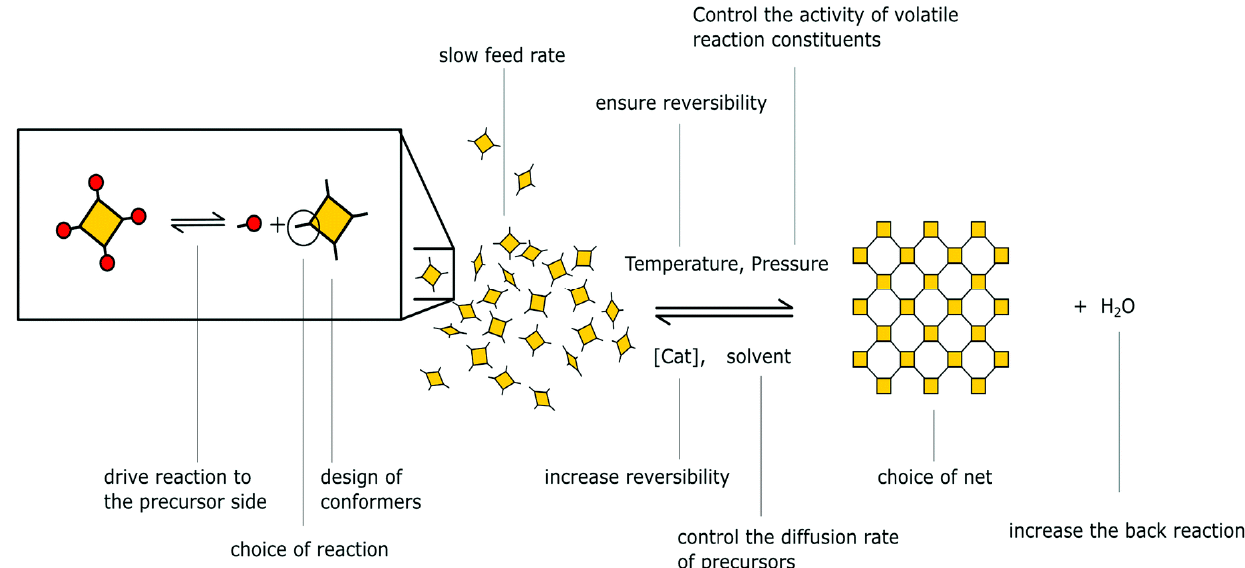
Figure 5. Three different methods to obtain good crystallinity COFs.